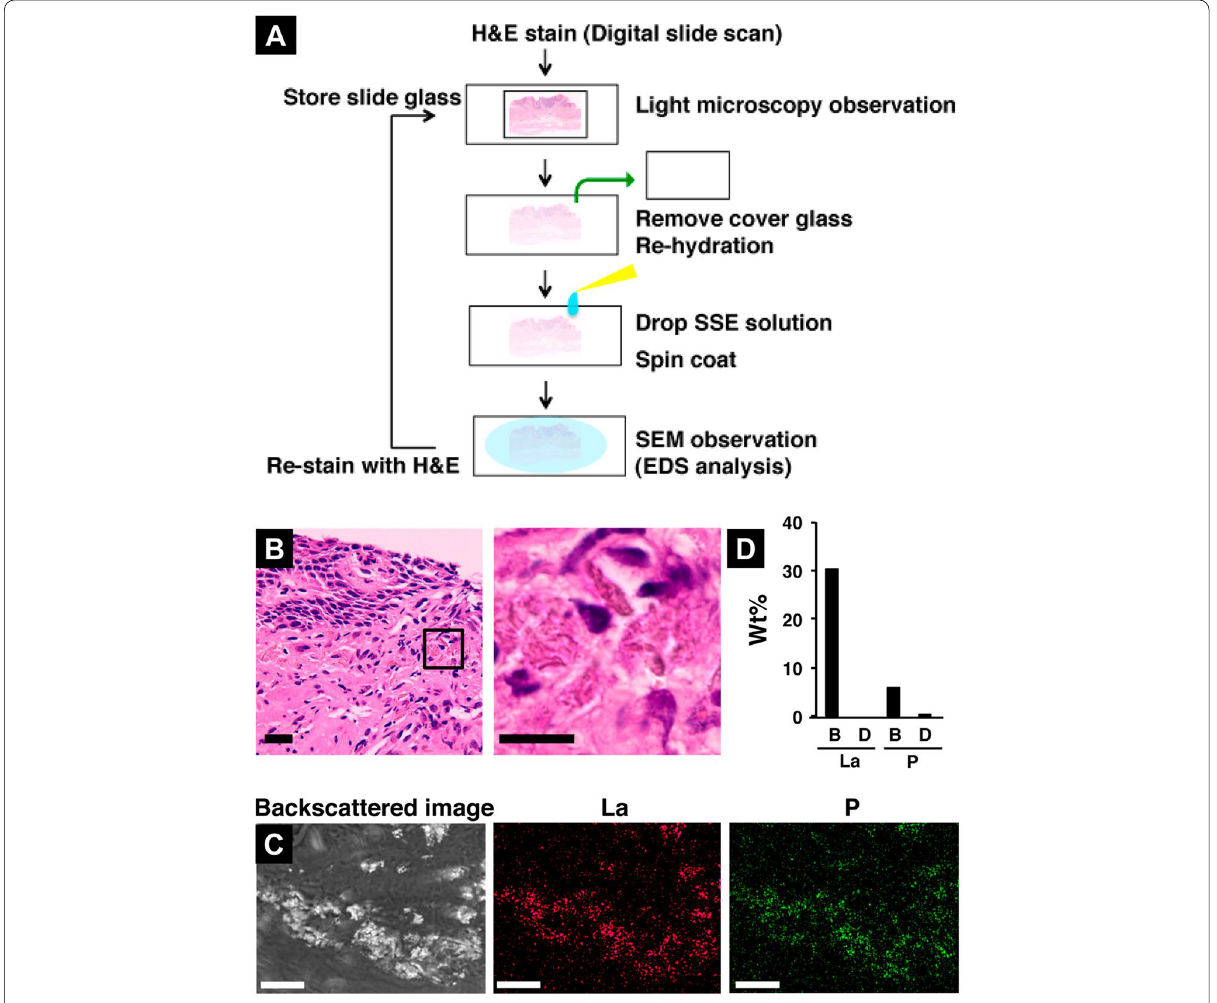
Fig. 7 Correlative microscopy. A Schematic drawing of a correlative electron and light microscopy workflow with SEM observation and X-ray microanalysis. B Left: H&E-stained esophageal mucosa containing brown pigment deposition. Bar Left.